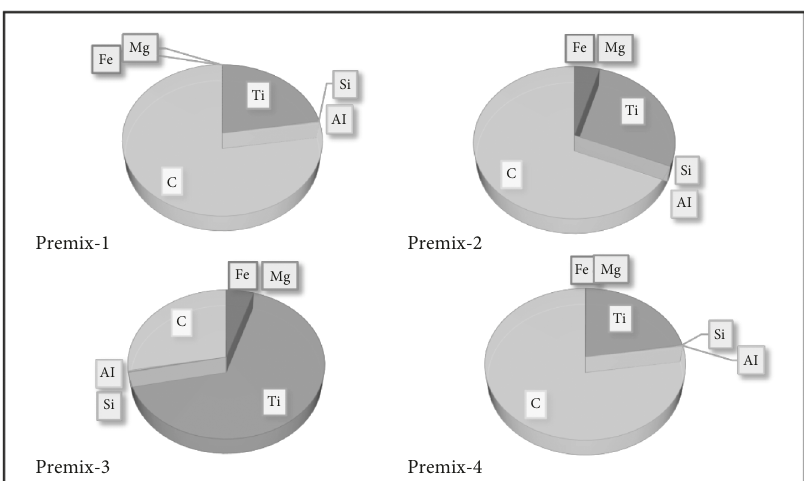
Figure 6: Relative abundances of selected element at the targeted surface area of Indian premixes 1–3 and UofT positive control 4. Table 2: Total iron content and iron release at pH 4 within 2 hrs.